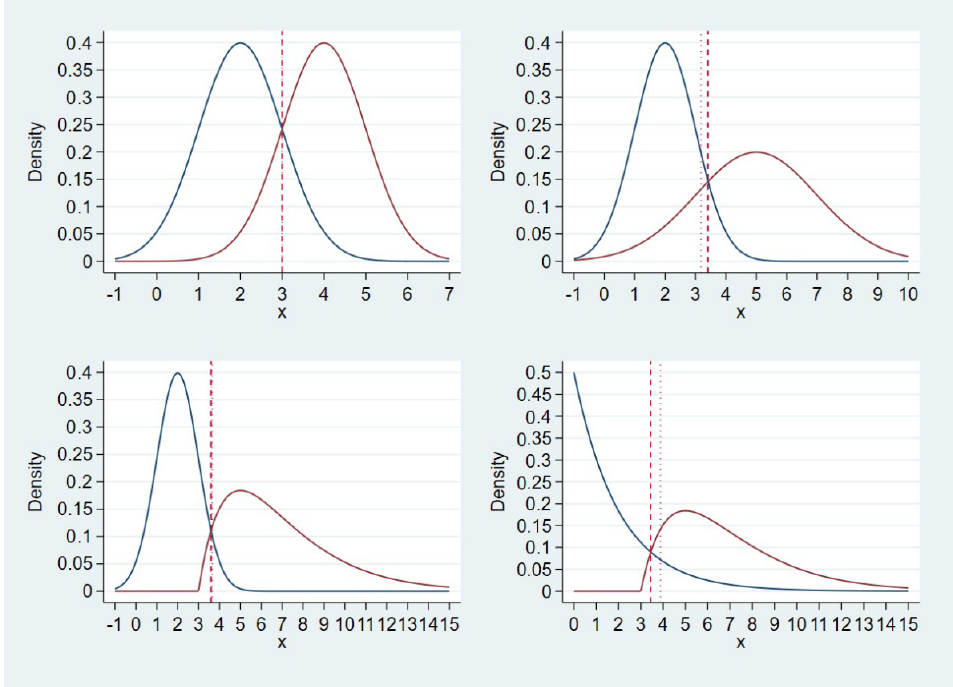
Figure 1. Four sets of assumed distributions for D0 (left, blue line) and D1 (right, red line) subjects. Top left: scenario 1—normal (mean = 2, variance = 1) and normal (mean = 4, variance = 1). Top right: scenario 2—normal (mean = 2, variance = 1) and normal (mean = 5, variance = 2). Bottom left: scenario 3—normal (mean = 2, variance = 1) and gamma (shape = 2, scale = 2, location = 3). Bottom right: scenario 4—exponential (scale = 2) and gamma (shape = 2, scale = 2, location = 3). The vertical, dashed line indicates the optimal cut-off point according to the Youden index, which was 3, 3.42, 3.6, and 3.45 for scenarios 1–4, respectively. The vertical, dotted line indicates the optimal cut-off point according to the closest-to-(0,1) criterion, which was 3, 3.18, 3.65, and 3.88 for scenarios 1–4, respectively.